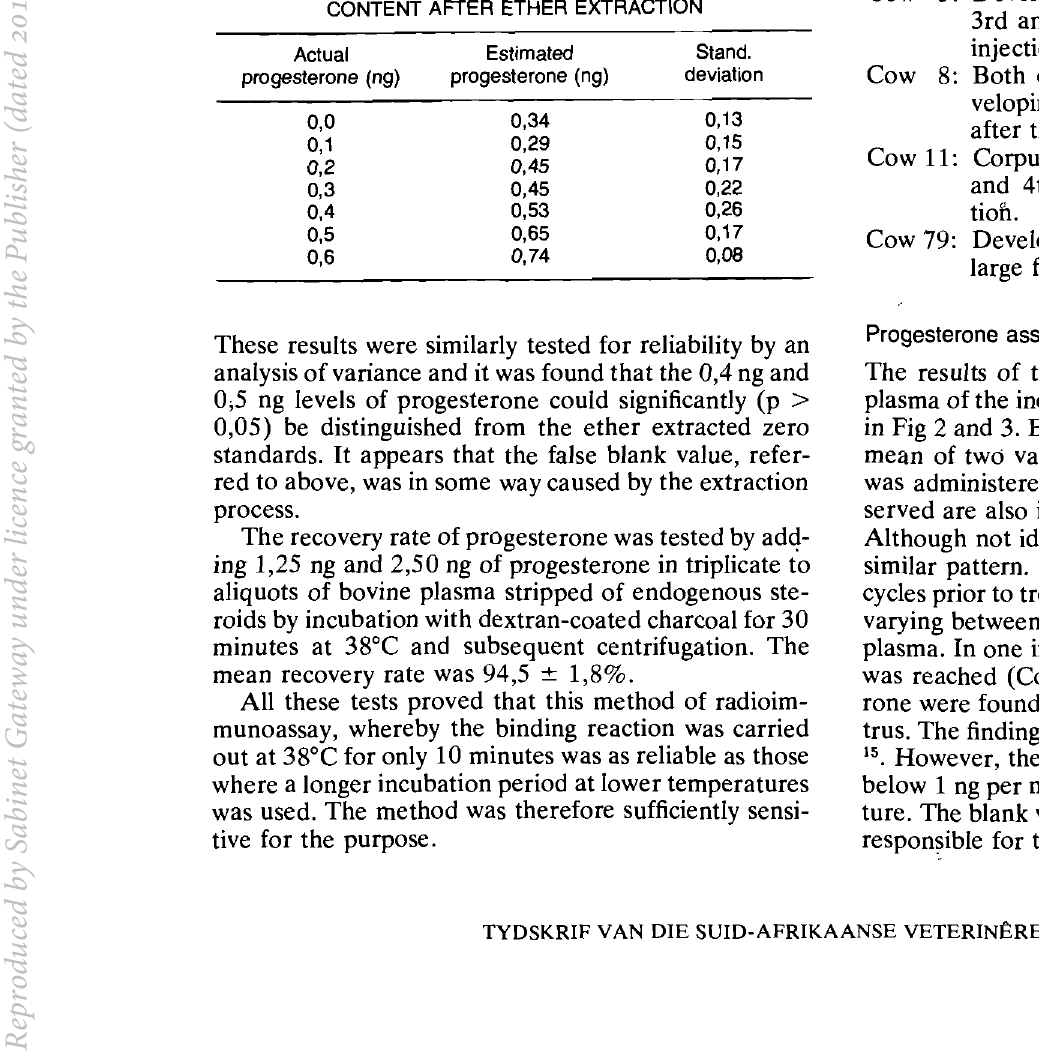
Table 3: THE ESTIMATED PROGESTERONE LEVELS IN STANDARD SOLUTIONS WITH LOW PROGESTERONE CONTENT AFTER ETHER EXTRACTION